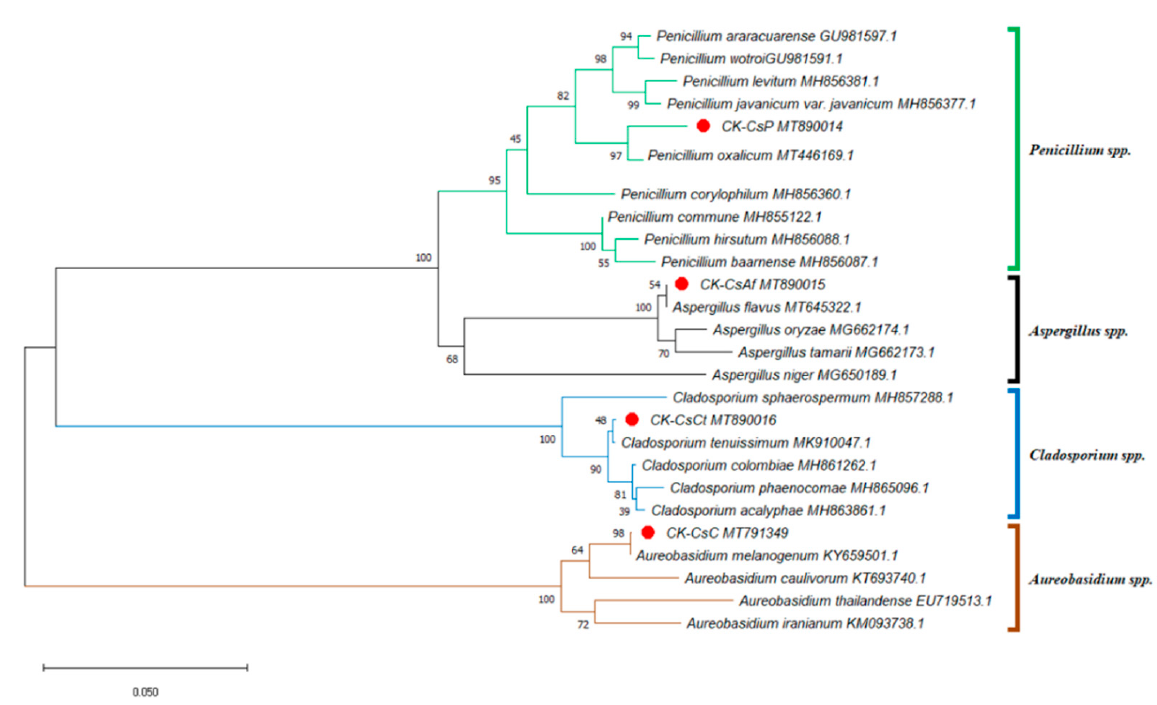
Figure 1. Phylogenetic tree of the isolated fungi constructed using the sequences of internal transcribed spacer regions (incl. 5.8S rDNA) (ITS). The isolated fungi were labeled as a red spot. Sequences for the ITS phylogenetic analysis were obtained from the GenBank database for the following strains: Aspergillus flavus, Aspergillus niger, Aspergillus tamarii, Aspergillus oryzae, Aureobasidium caulivorum, Aureobasidium iranianum, Aureobasidium thailandense, Aureobasidium melanogenum, Cladosporium acalyphae, Cladosporium colombiae, Cladosporium phaenocomae, Cladosporium sphaerospermum, Cladosporium tenuissimum, Penicillium araracuarense, Penicillium baarnense, Penicillium corylophilum, Penicillium commune, Penicillium hirsutum, Penicillium vavanicum var. javanicum, Penicillium levitum, Penicillium oxalicum, Penicillium wotroi. The GenBank accession number is included after the fungal scientific name. The tree was constructed using the neighbor-joining method and tested by bootstrapping with 1000 replicates of data. Percentages are reported at nodes, and the scale bar represents 0.05% sequence divergence.